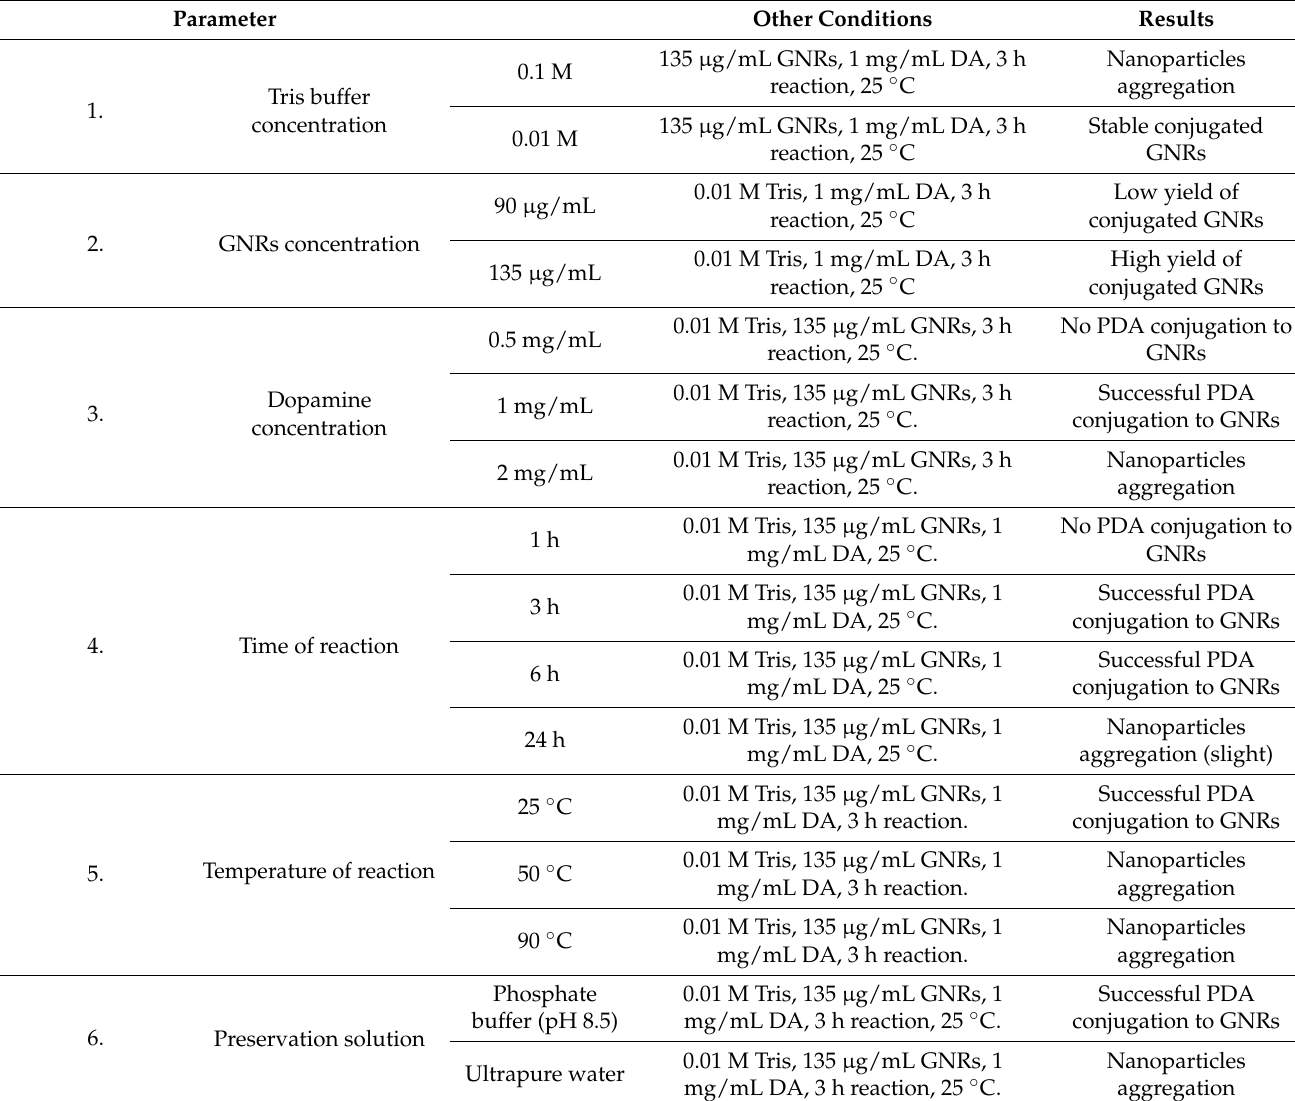
Table 1. Parameters used for production of PDA-conjugated